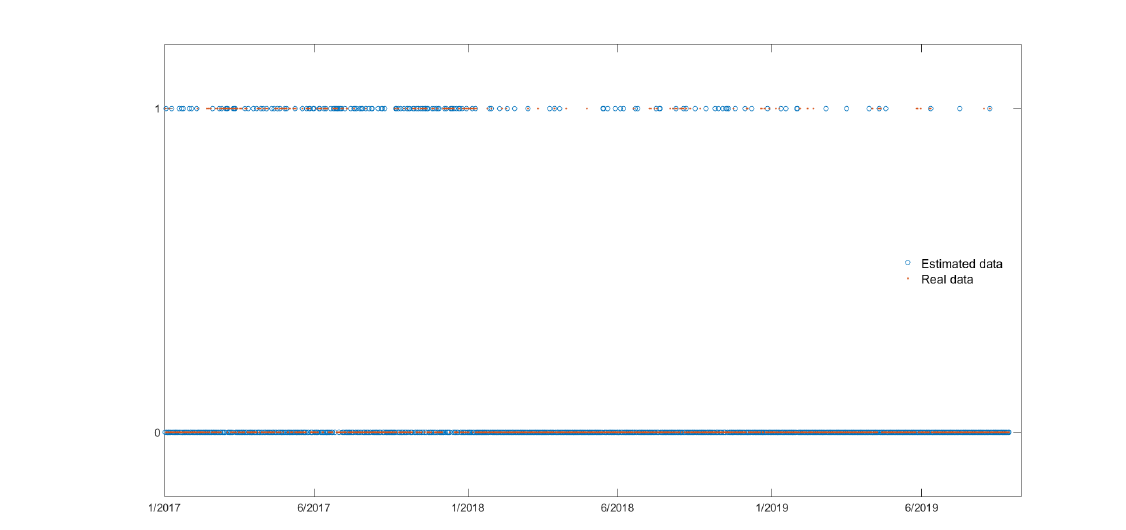
Figure 2. Realization of the binary ETH series with α = 5% using the logistic regression model. The blue circles represent the realized series whereas the red dots are the actual data points.